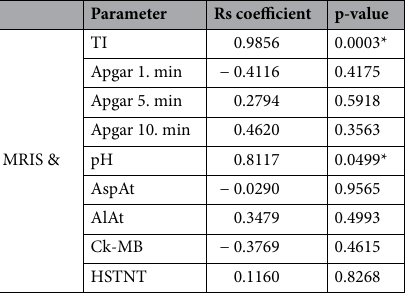
Table 3. Correlation between the MRI scale (MRIS) and the analyzed parameters (the Spearman rank correlation coefficient). *Significant correlation (p < 0.05).